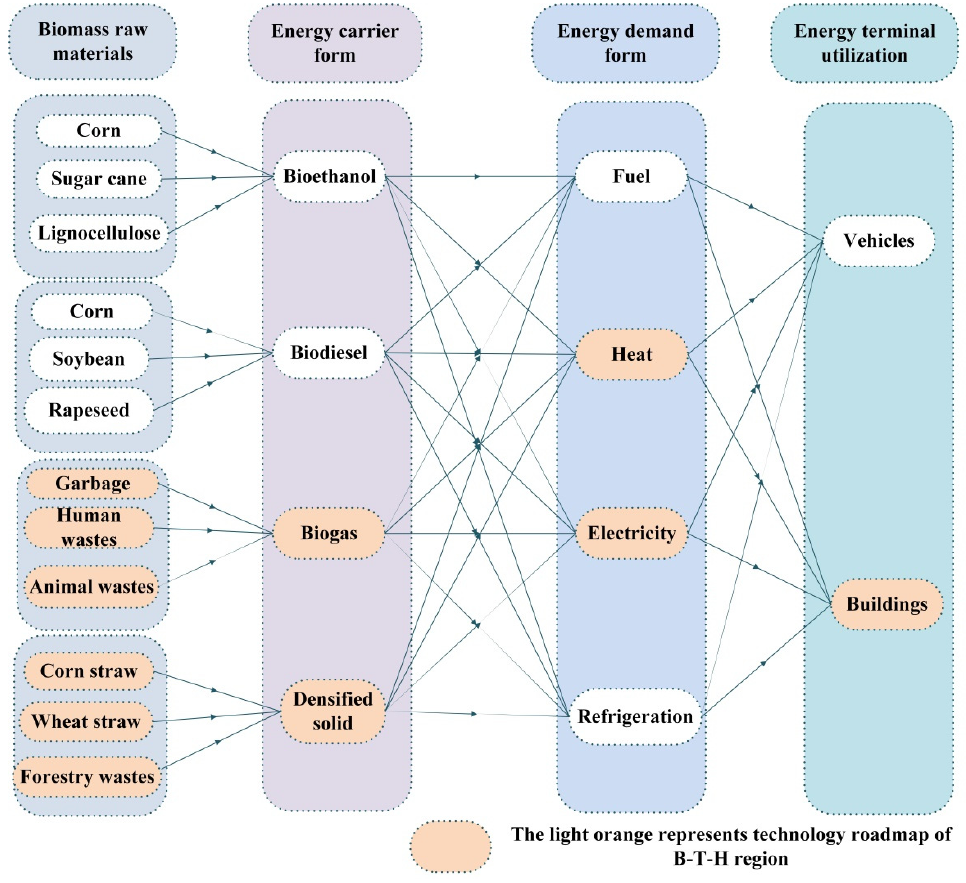
Figure 7. The suitable technology roadmap of biomass energy development in the B-T-H region.